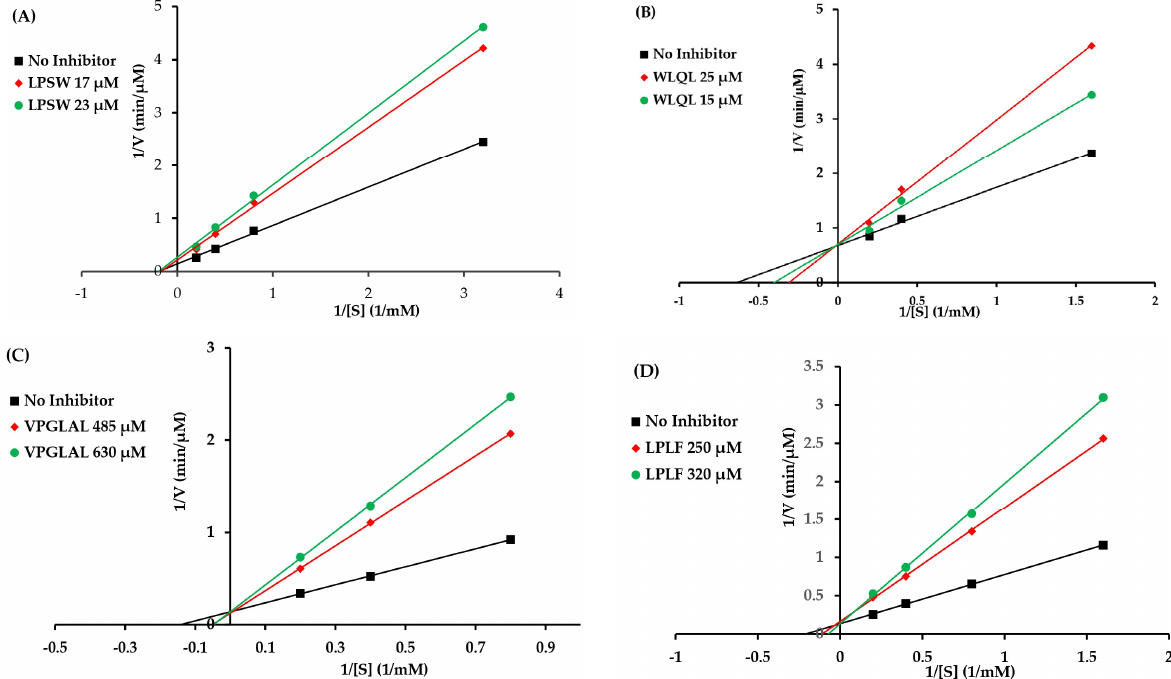
Figure 1. Lineweaver–Burk double reciprocal plots for ACE inhibition with ( A ) LPSW (non ‐ com ‐ petitive), ( B ) WLQL (competitive), ( C ) VPGLAL (competitive), and ( D ) LPLF (competitive) deter ‐ mined at concentrations close to their IC 50 values. Table 2. Kinetic constants of enzyme ‐ catalyzed reactions at different peptide concentrations.